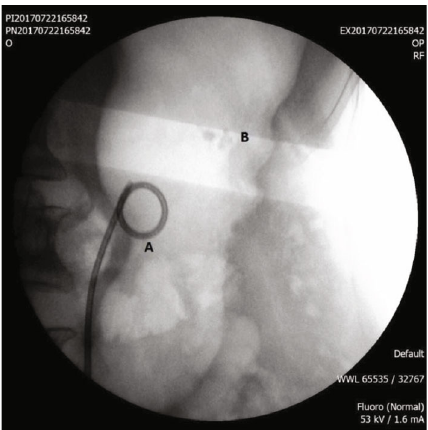
Figure 1: A: double pigtail stent (CH6) placed to dilate the ureter. B: 3 stone-bearing diverticula in middle calyces.